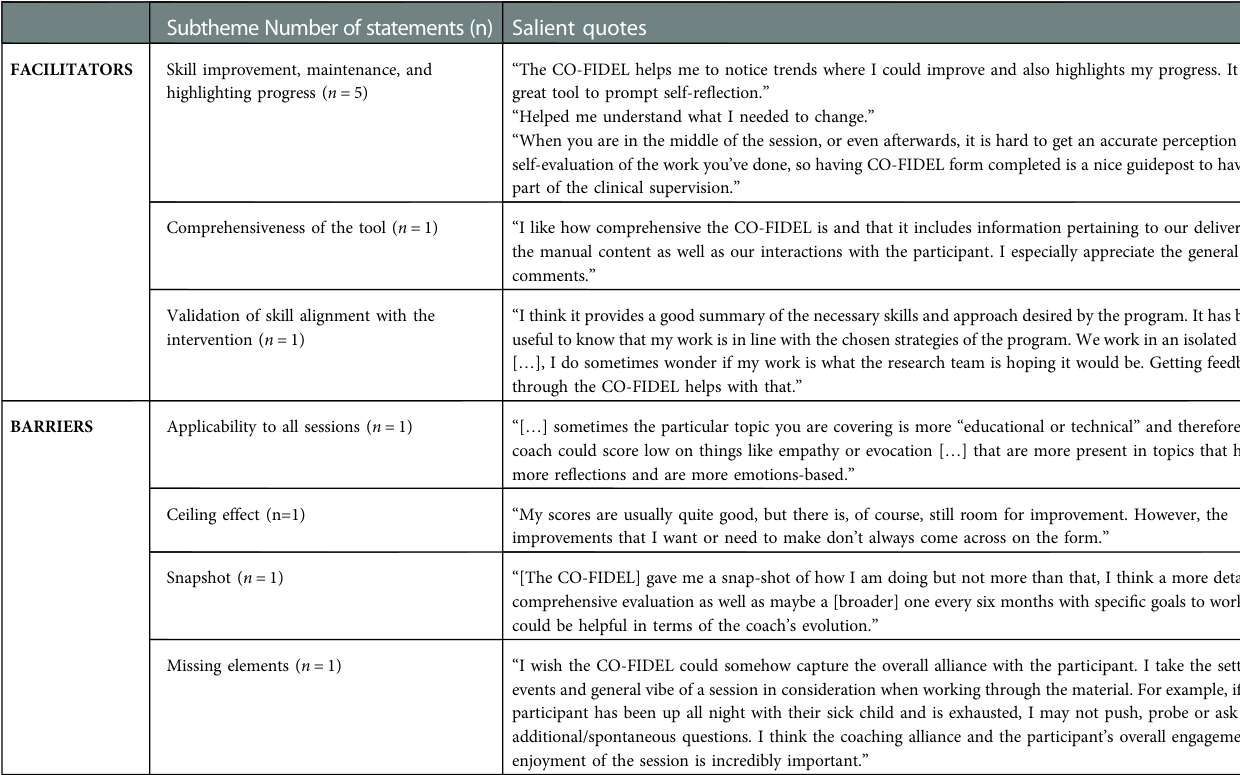
TABLE 4 Statement examples for emerging sub-themes of facilitators & barriers. Subtheme Number of statements (n) Salient